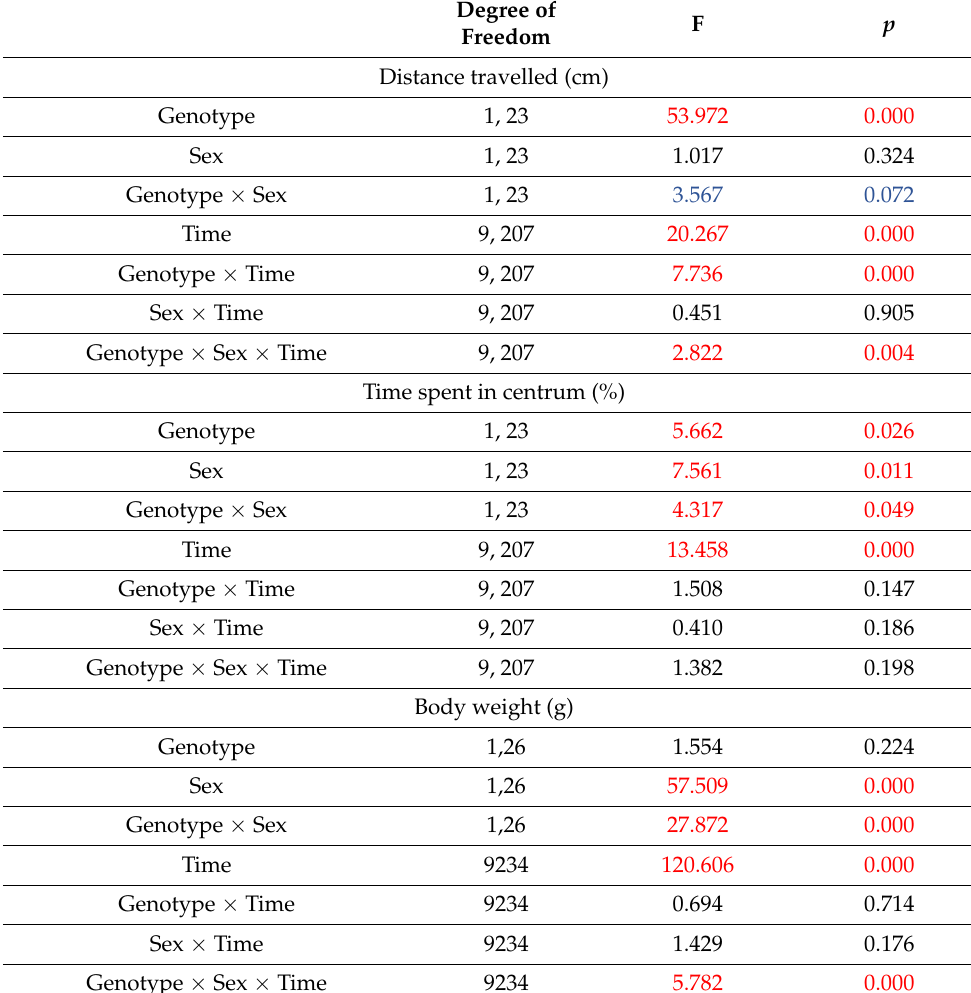
Table 4. Statistical data (results of mixed ANOVA) of open-field test (Experiment 2) and corre- sponding body weight in male and female, control and 3xTg-AD mice. The corresponding data are presented on Figure 4. Repeated measurements were conducted from 2 to 11 month of age. Significant main effects are highlighted in red, while blue colour represents marginally significant